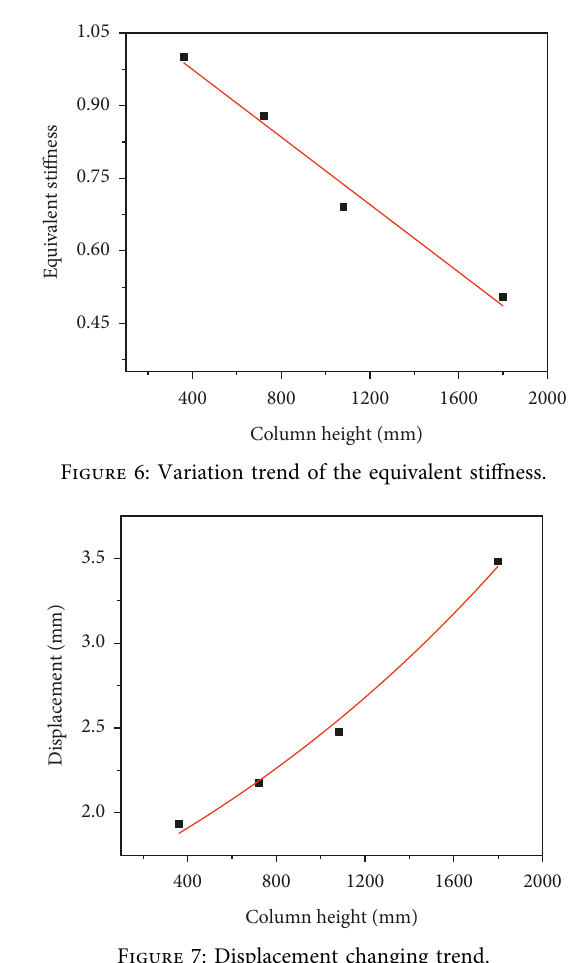
Figure 5: Load-displacement relationship.